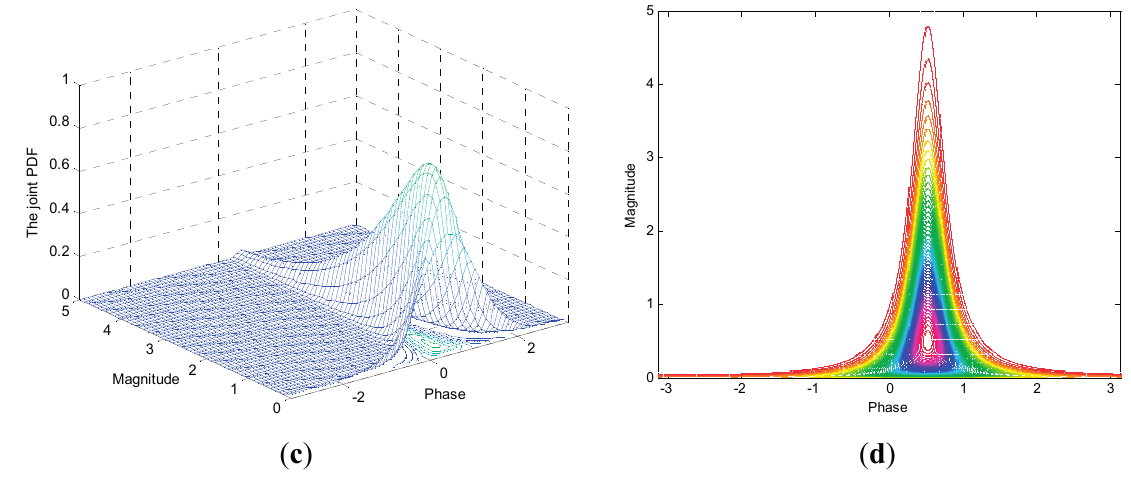
Figure 5. Joint distribution of the interferometric magnitude and phase: ( a ) The 2-D joint PDF with the parameters θ = 0, ρ = 0.9596 and n = 1; ( b ) The contour line of (a) in the M-P plane; ( c ) The 2-D joint PDF with the parameters θ = π /6, ρ = 0.9596, and n = 1; ( d ) The contour line of (c) in the M-P